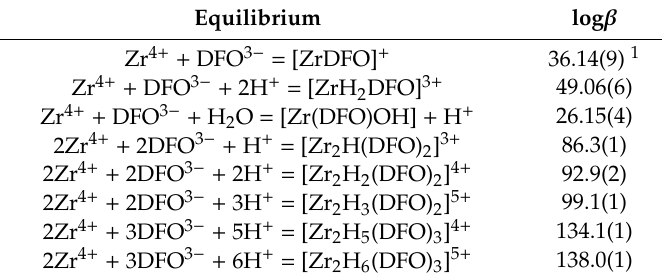
Table 1. Equilibrium constants of the complexes formed by Zr 4 + with desferrioxamine (H 3 DFO) in 0.1 M NMe 4 Cl at 298.1